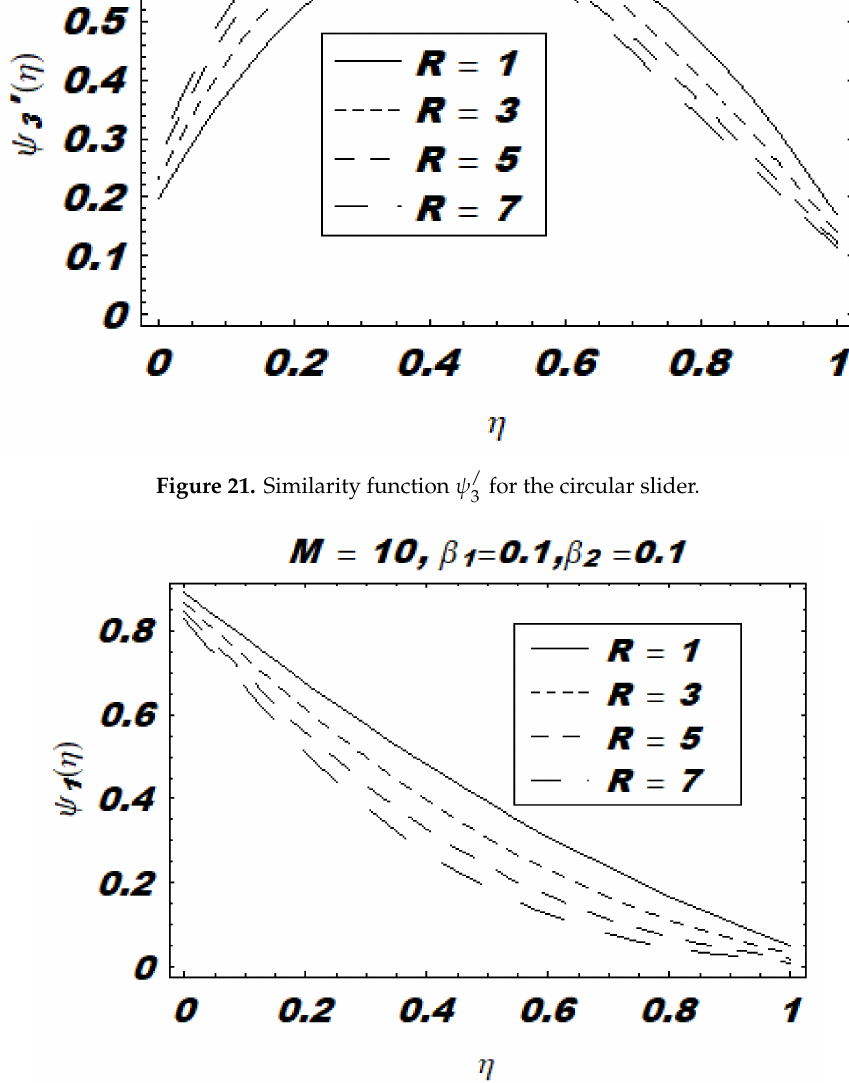
Figure 22. Similarity function ψ 1 for the circular